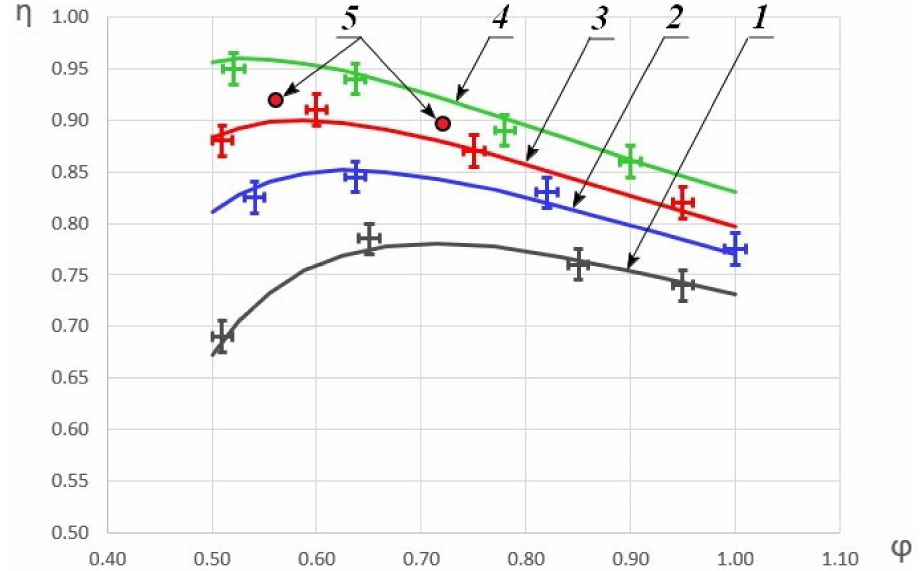
Figure 4. Dependence of the combustion completeness coefficient on the fuel excess coefficient. 1— H = 360 kJ/kg; 2— H = 490 kJ/kg; 3— H = 580 kJ/kg; 4— H = 690 kJ/kg; 5—the data from the study [48] where H ≈ 580